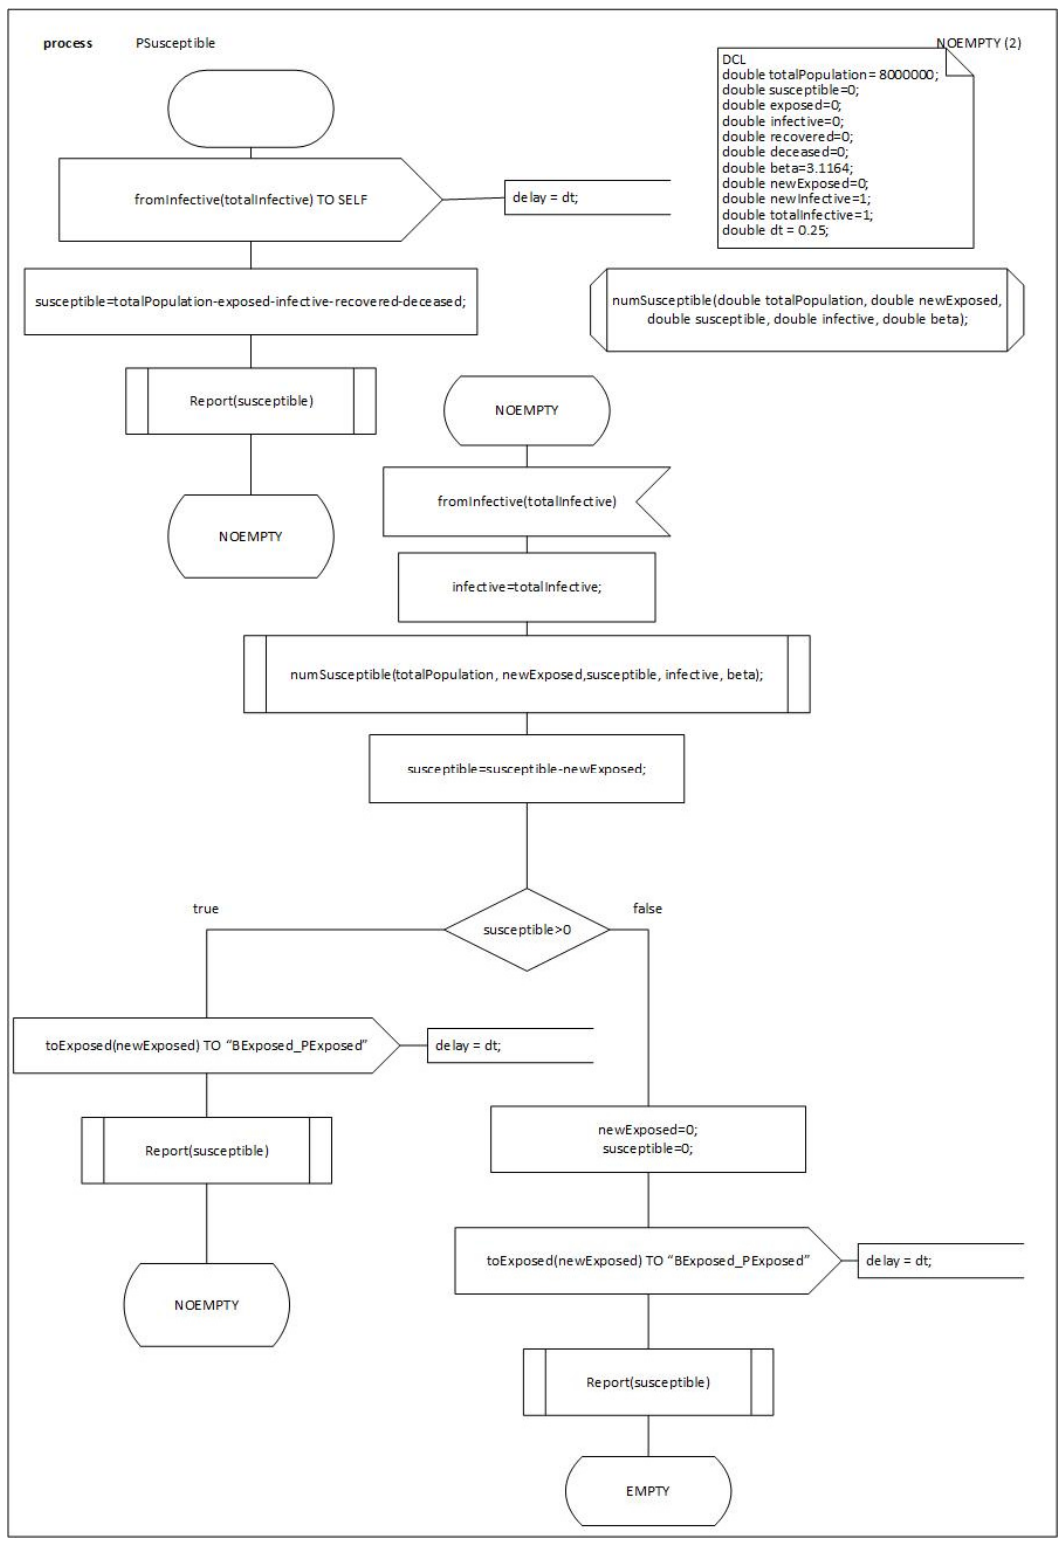
Figure 7. PSusceptible PROCESS diagram. This diagram shows the initialization of the model where the first EVENT fromInfective , defines the initial number of infective individuals we have in the model. When we receive this SIGNAL, we start the dynamics of the model, which in SD is represented in the equations, but here is represented in the diagrams. We calculate with PROCEDURE numSusceptible , the number of exposed individuals that will be sent to the BExposed BLOCK, numExposed